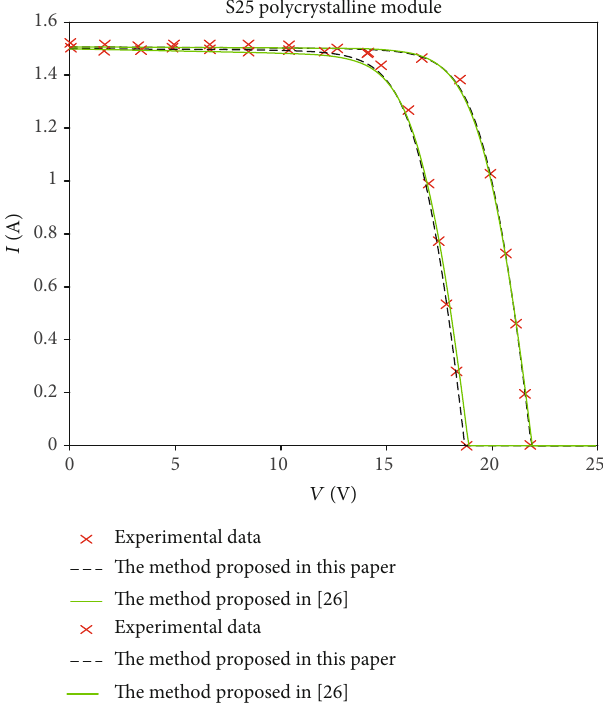
Figure 8: I – V characteristics under varying temperature for S25 polycrystalline module ( G = 1000 W/m 2